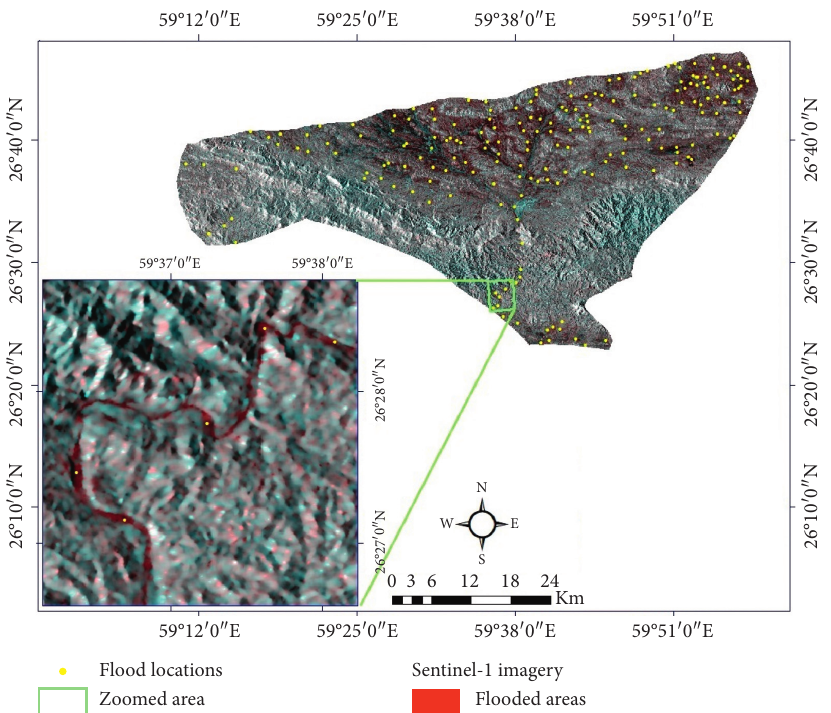
Figure 11: Flood detection using Sentinel-1.